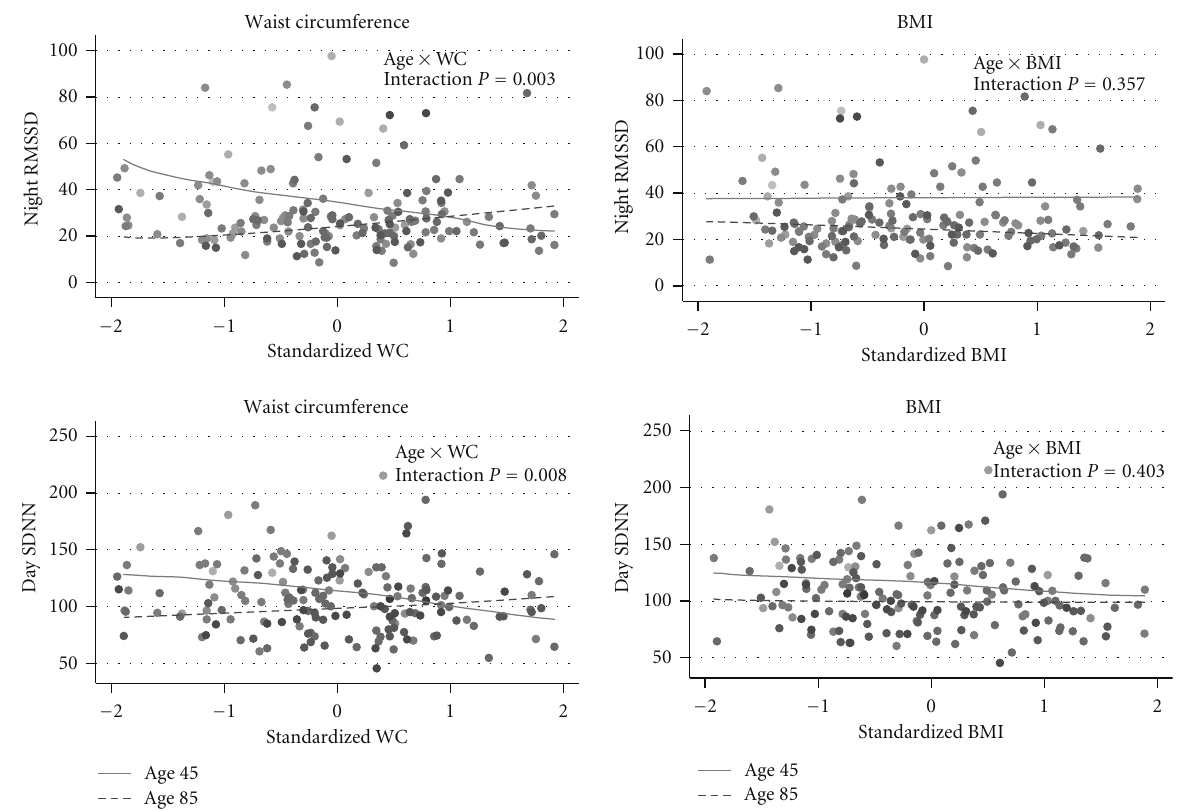
Figure 2: Data points are observed data; lines represent the predicted value of nighttime RMSSD (top row) and daytime SDNN (bottom row) (if the adiposity measure increased for an average participant at two ages: 45 years (solid lines) and 85 years (dashed lines)). Standardized waist circumference and standardized BMI are shown on x -axes to scale the measures similarly. The figures show di ff ering relationships between waist circumference and HRV measures at young and old ages but not between BMI and HRV measures. Negative relationships were observed between waist circumference and RMSSD and SDNN in the 45 yo but no significant relationship in the 85yo. Comparatively, the SDNN-BMI relationship is attenuated, compared to WC, for the 45-year olds and the RMSSD-BMI relationship is relatively flat at 45 and 85 years, with neither being statistically significant. ∗ x -axes are standard deviations from mean waist circumference (women: 88cm, men: 98cm) or BMI (27kg/m 2 ). ∗ Graded gray-scale data points from population illustrate increasing age (lighter is younger, darker is older, 26–96 y). Models were adjusted for sex, race, OGTT glucose, blood pressure, and the interactions age-by-sex, age-by-race, the sex- by-OGTT glucose. OGTT glucose = 2-hour oral glucose tolerance test glucose result; RMSSD:root mean square of successive di ff erences; SDNN:standard deviation of N-N